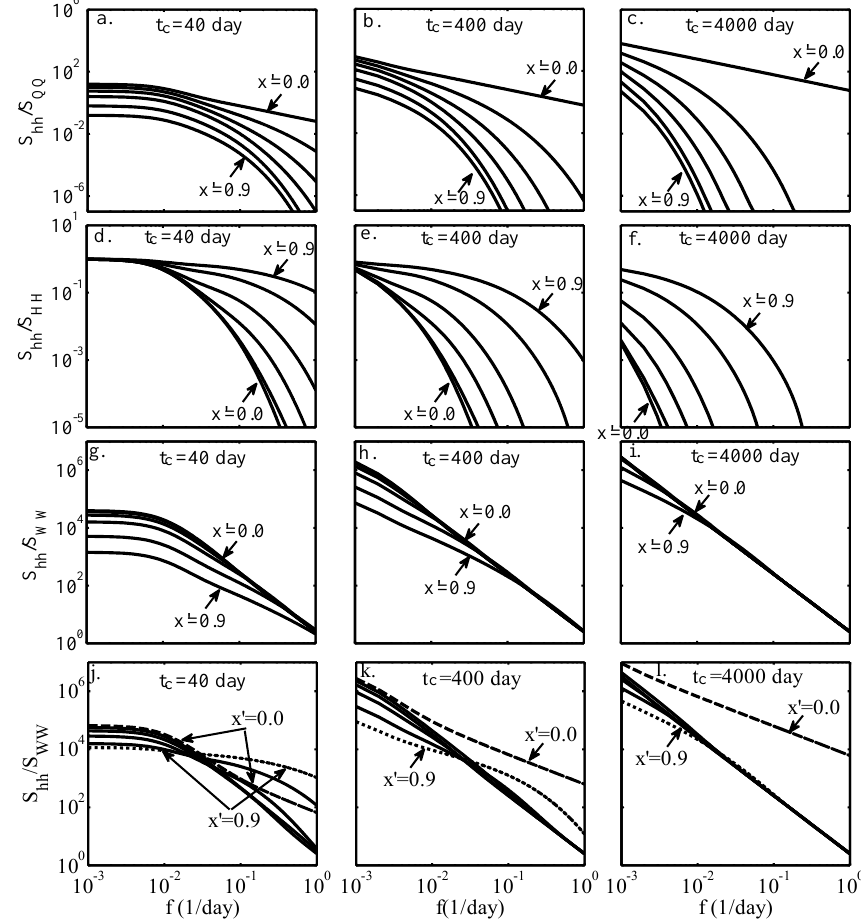
Figure 3. The dimensionless power spectrum versus frequency ( f ) at the dimensionless locations x (cid:48) = 0.0, 0.2, 0.4, 0.6, 0.8, and 0.9. The graphs on the left column show t c = 40 days, the graphs on the middle column show t c = 400 days, and the graphs on the right column show t c = 4000 days. The graphs on the first row show the dimensionless spectrum S hh / S QQ when S WW = 0, S HH = 0, and S QQ (cid:54)= 0 in Eq. (10); the graphs on the second row show S hh / S HH when S WW = 0, S QQ = 0, and S HH (cid:54)= 0; the graphs on the third row show S hh / S WW when S QQ = 0, S HH = 0, and S WW (cid:54)= 0; and the graphs on the bottom row show S hh / S WW when S QQ (cid:54)= 0, S HH (cid:54)= 0, and S WW (cid:54)=